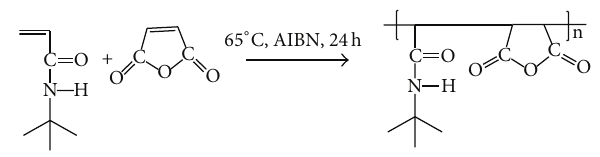
Scheme 1: Polymerization reaction of